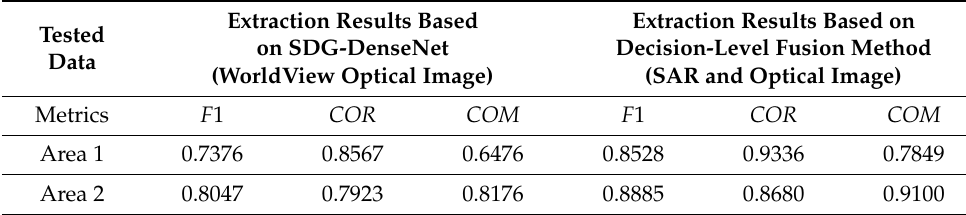
Figure 25. Tested data Area 2. Some details in optical and SAR remote sensing images and road extraction results in the Wuzhen area. ( a ) Worldview-4 optical remote sensing image; ( b ) road extraction results of optical remote sensing image; ( c ) road extraction results from SAR remote sensing images; ( d ) road fusion extraction results of optical and SAR images; ( e ) ground truth and marking results of road fusion extraction results (green refers to the correctly extracted road, red refers to the incorrectly extracted road, and yellow refers to the omitted real road). Table 6. The results of two large scale images for the whole